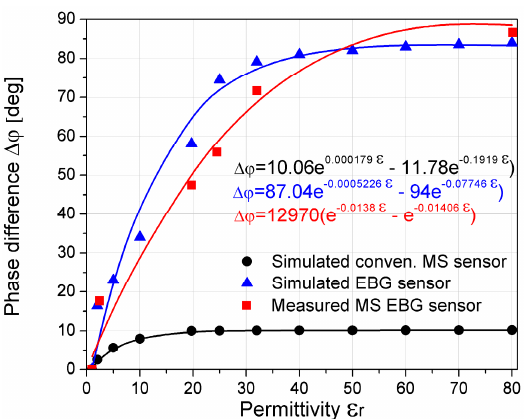
Figure 11. Sensitivity of the proposed EBG sensor compared to the conventional microstrip line sensor (dots) and the corresponding fitting curves (lines) with equations.